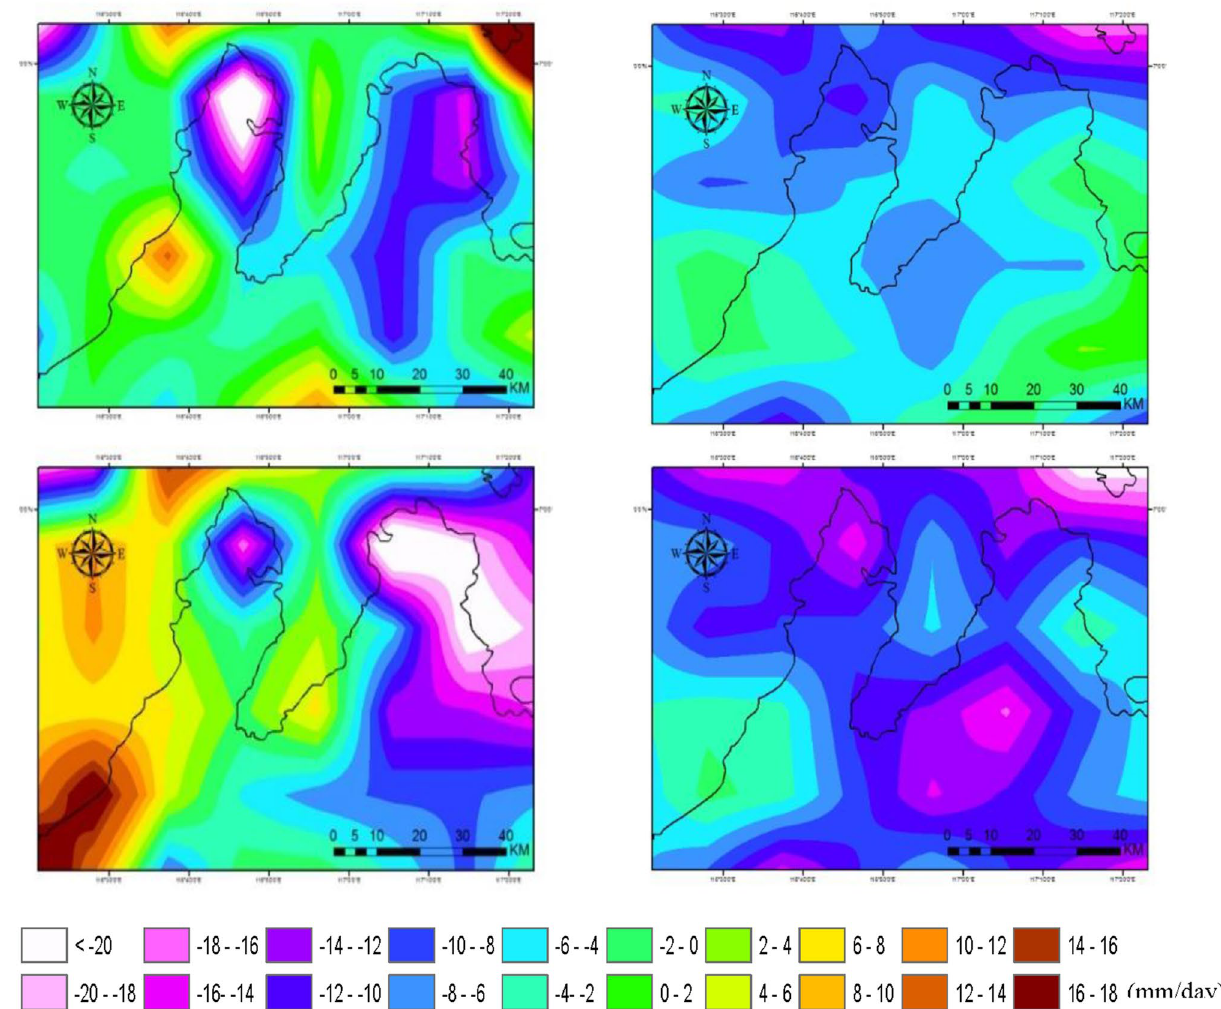
Fig. 5 Spatial changes of seasonal mean total precipitation (mm/day) change for 2050 (left panel) and 2100 (right panel) relative to baseline (2010) during the winter (top panel) and summer (bottom panel) under RCP